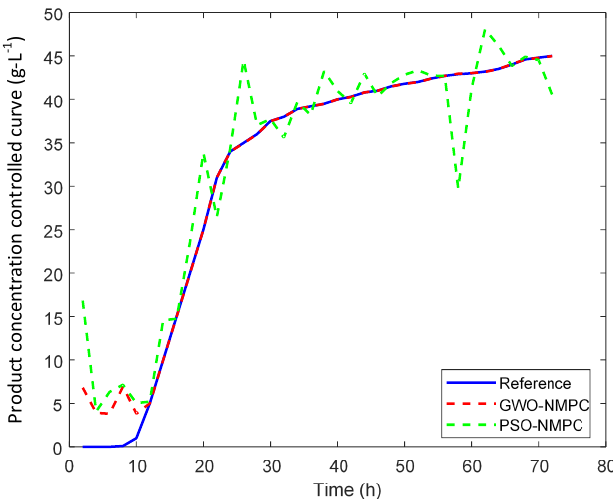
Figure 7. GWO-NMPC controlled product concentration output with optimal reference.